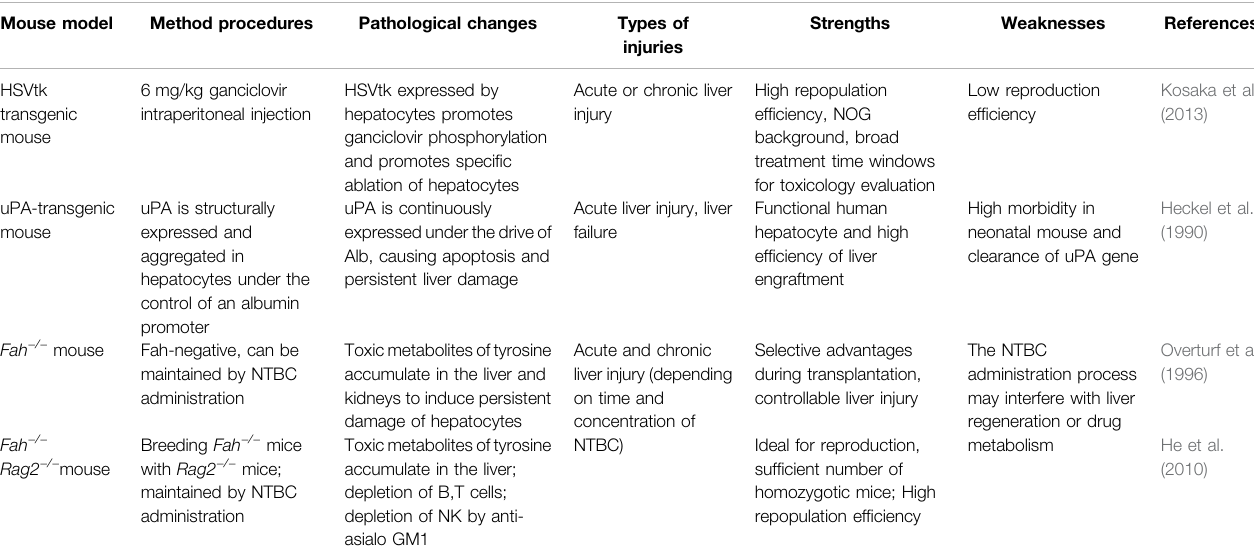
TABLE 6 | Mouse models of cell transplantation and liver